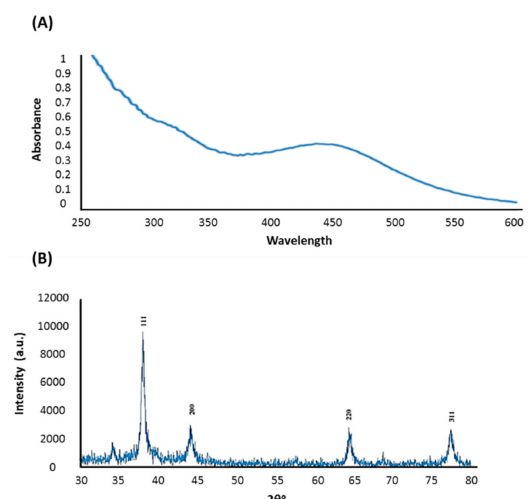
Figure 2. Characterization of AgNPs synthesized by C. gigantean in aqueous solution. ( A ) UV-vis absorption spectrum of synthesized AgNPs by a C. gigantean leaf extract incubated with silver nitrate (1 mM). The peak values are for the UV-vis plotted between AgNPs / absorbance ratios. The highest absorbance peak was at about 450 nm, corresponding to the plasmon resonance of AgNPs. ( B ) XRD spectrum recorded for AgNPs showed four distinct di ff raction peaks at 38.18 ◦ , 44.35 ◦ , 64.4 ◦ , and 77.3 ◦